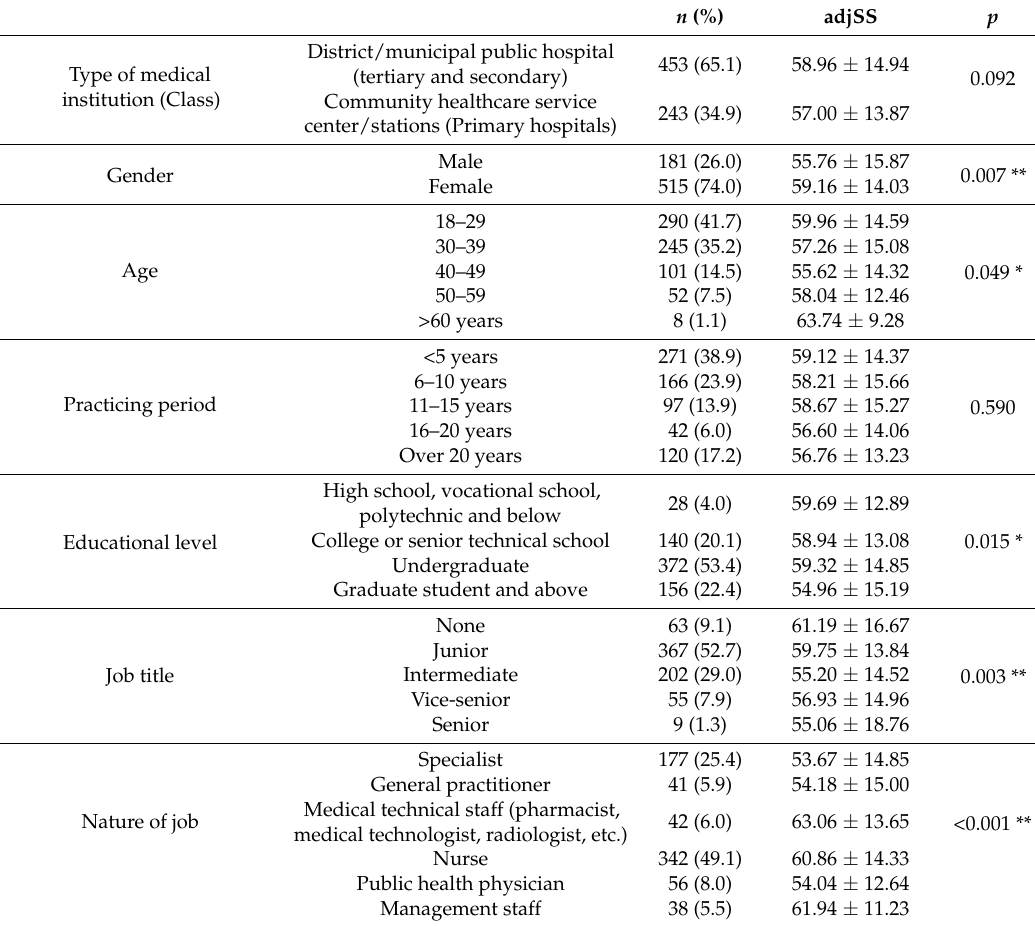
Table 4. Demographic characteristics associated with the medical staff’s job satisfaction ( N =